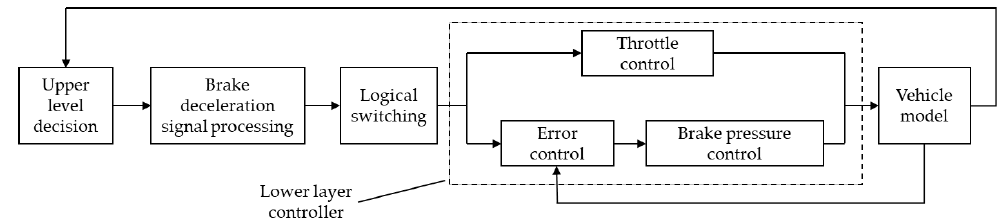
Figure 4. AEB system structure.